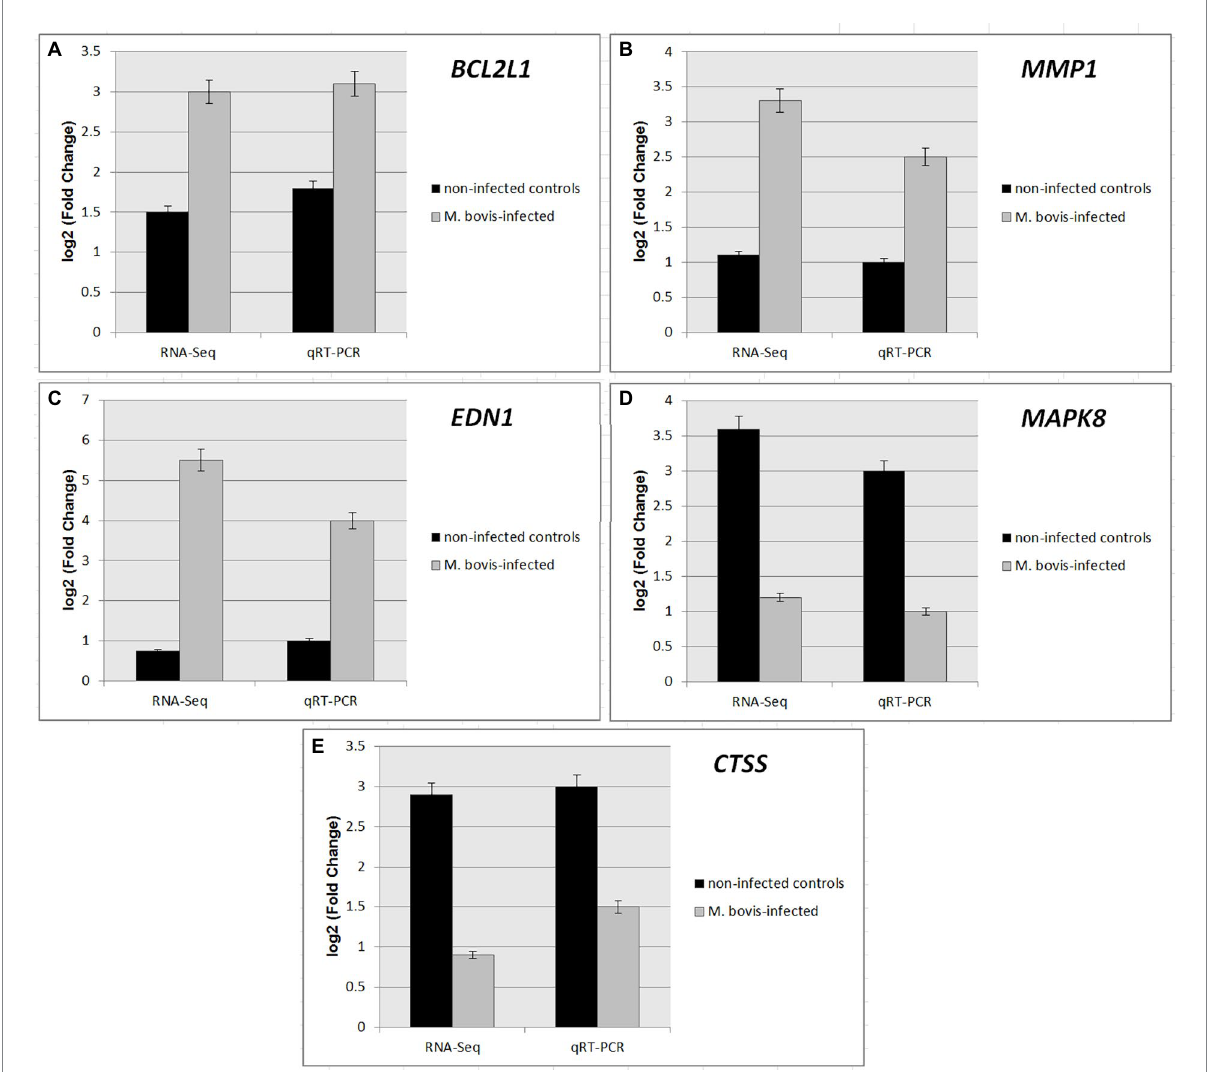
FIGURE 9 Differentially expressed genes were selected from transcriptome comparison combinations at different non-infected control vs. M. bovis -infected samples. The black-filled columns represent the relative mRNA expression levels obtained by qRT-PCR, which were normalized by GAPDH